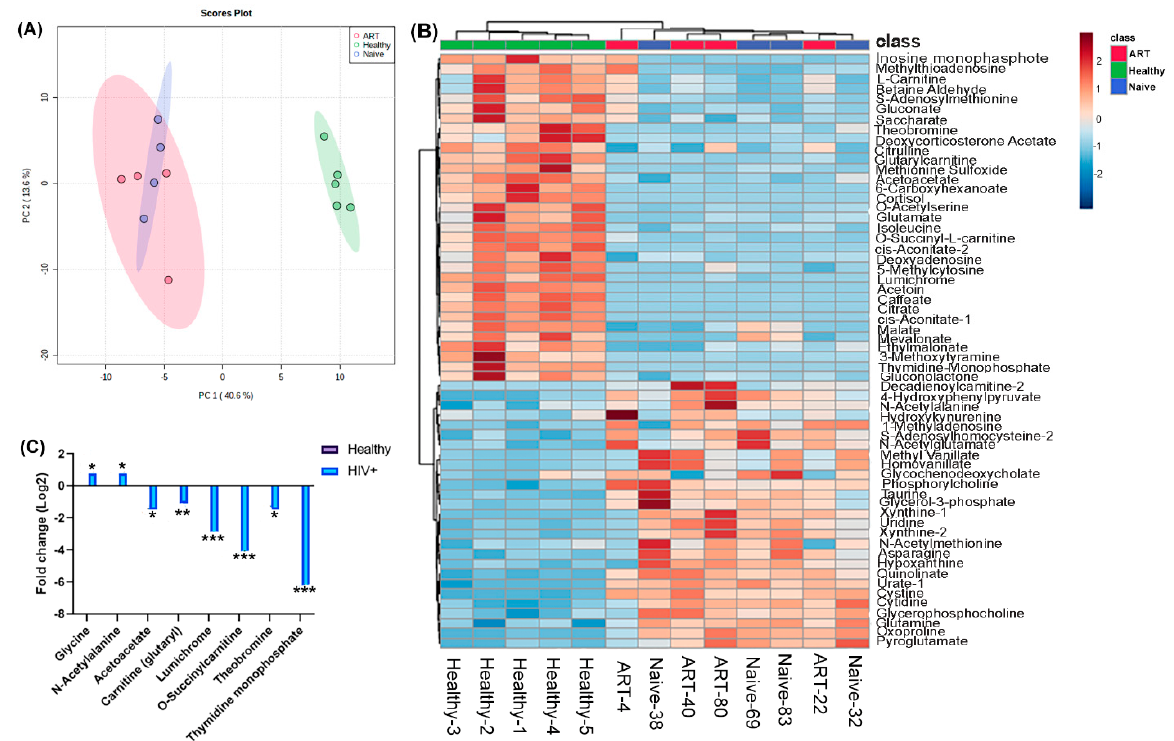
Figure 1. Plasma metabolic profiles of HIV+ patients (treatment-naïve and ART-treated): ( A ) Scatter plot showing partial least-square discriminant analysis (PLS-DA) of plasma metabolomic profiles. The two principal components explaining the highest variance were plotted on X and Y axis; ( B ) heatmap shows the top 60 differentially abundant metabolites identified in a comparison between healthy donors and HIV patients at 5% FDR; ( C ) fold change in abundance of 6 selected metabolites computed from metabolome profiles in a comparison between HIV patients and healthy donors. The bars represent log2 fold change in HIV patients compared with healthy donors. The asterisks *, **, and *** denote FDR < 0.05, FDR < 0.01, and FDR < 0.001, respectively.